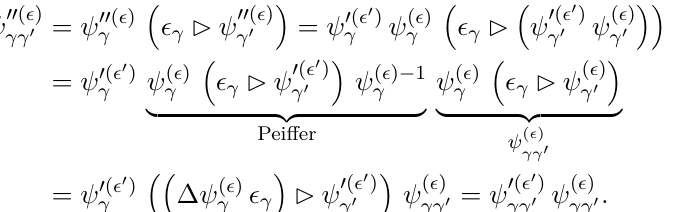
Figure 15 . Illustration of the semi-direct product structure of the group E (0) vertex and edge